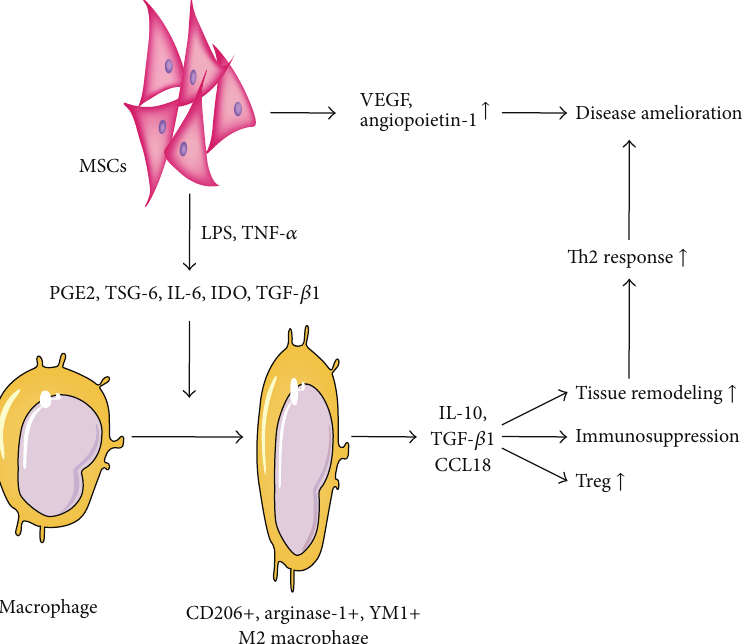
Figure 1: Mechanisms of macrophage polarization induced by MSCs in disease amelioration. MSCs produce paracrine factors such as PGE2, TSG-6, IL-6, IDO, and TGF- 𝛽 1 when stimulated by proinflammatory mediators (LPS and TNF- 𝛼 ). The paracrine factors promote M2 macrophage polarization, which leads to increased Th2 response (upregulation of Treg and tissue remodeling as well as immunosuppression). MSCs also facilitate the production of VEGF and angiopoietin-1 which enhance angiogenesis. The net effect is disease